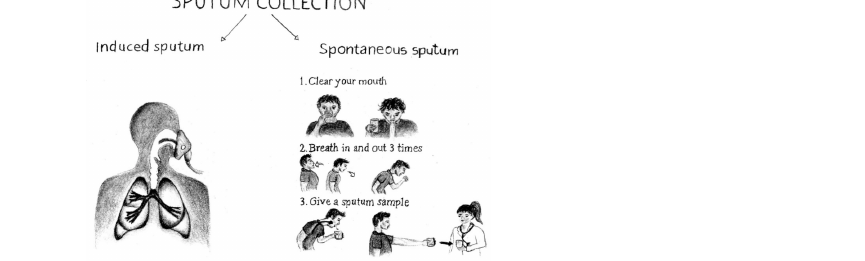
Figure 2. Cartoon showing the different procedures for induced ( left ) and spontaneous ( right ) sputum